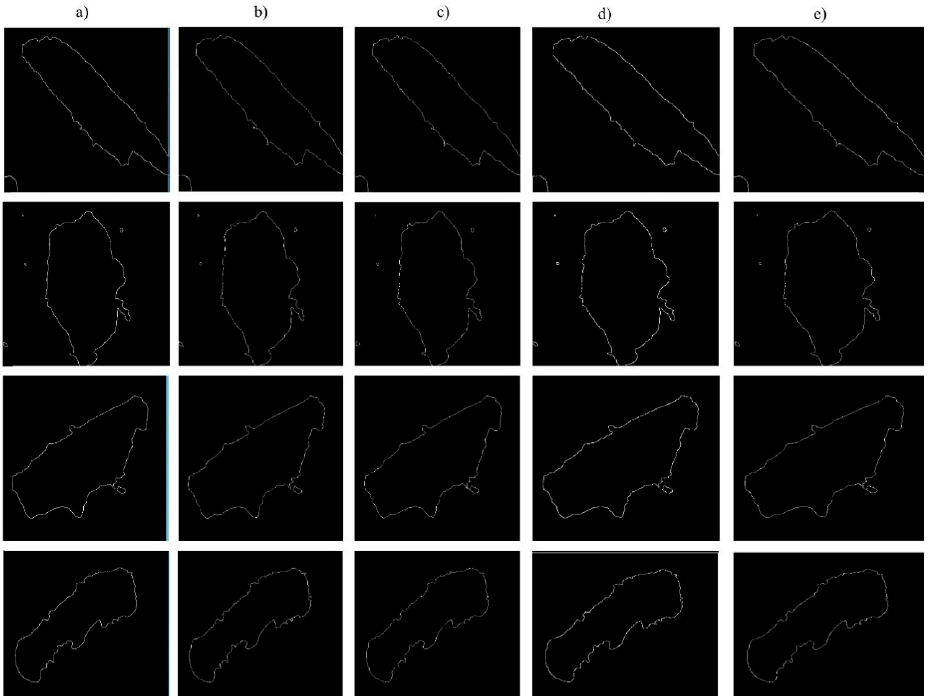
Figure 3. Extraction of the contour of wood powder particles: ( a ) Canny operator; ( b ) Log operator; ( c ) Prewitt operator; ( d ) Roberts operator; ( e ) Sobel operator.